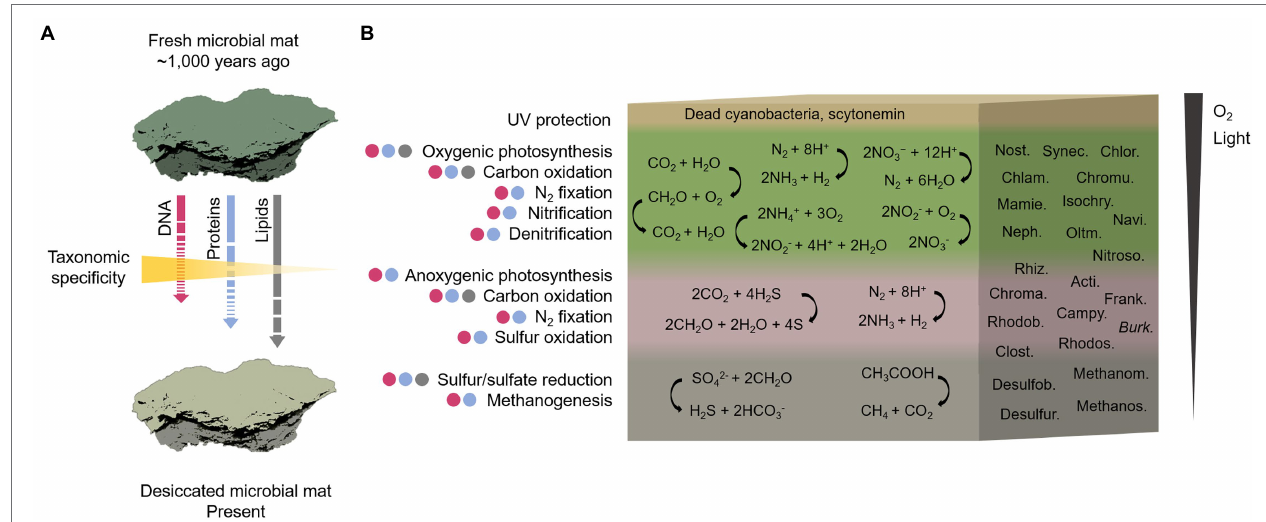
FIGURE 9 | Reconstructive sketch of the biological composition and metabolisms that operated in the ancient microbial mat on the MIS before desiccation. In (A) , the temporal shift of the microbial mat from the hypothetical scenario of a fresh and photosynthetically active microbial mat ~1,000 years ago to the present desiccated state. The length and continuity/discontinuity of the arrows indicate an estimate of the degree of preservation of the three biomolecules studied (lipids > proteins > DNA) with an inverse gradient of taxonomic specificity. In (B) , reconstruction of the biological composition and metabolisms across a representative cross-section of the Bratina microbial mat. The cross-section shows a vertical stratification based on previous microbial mats descriptions (Vincent et al., 1993b; De los Rios et al., 2004; Prieto-Barajas et al., 2018). The presence of putative metabolic functions in each layer is the result of an integrative approach based on the identification of microbial taxa detected by DNA (purple circles), proteins (blue circles) and lipid biomarkers (grey circles) analyses. The metabolisms may not be exclusively associated with a certain layer. A global reaction for each metabolism is represented as an example. The most abundant taxa in the microbial mat determining the metabolisms are: Nostocales (Nost.), Synechococcales (Synec.), Chlorellales (Chlor.), Chlamydomonadales (Chlam.), Chromulinales (Chromu.), Mamiellales (Mamie.), Isochrysidales (Isochry.), Naviculales (Navi.), Nephroselmidales (Neph.), Oltmannsiellopsidales (Oltm.), Nitrosomonadales (Nitroso.), Rhizobiales (Rhiz.), Actinomycetales (Acti.), Chromatiales (Chroma.), Frankiales (Frank.), Rhodobacterales (Rhodob), Campylobacterales (Campy.), Burkholderiales (Burk.), Rhodospirillales (Rhodos.), Clostridiales (Clost.), Desulfobacterales (Desulfob.), Desulfuromonadales (Desulfur), Methanomicrobiales (Methanom.), and Methanosarcinales (Methanos.) For detailed information regarding the metabolisms inferred by the microbial taxa identity, see Supplementary Text 3